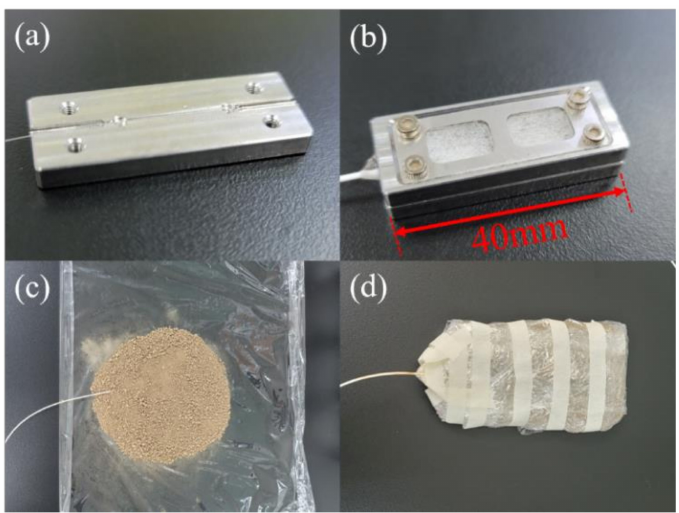
Figure 2. Installation of the experimental set-up. ( a ) The POFBG positioned in the V-groove; ( b ) sensor probe: the POFBG in the stainless-steel package with polypropylene mat as a filter; ( c ) the sensor probe embedded in soils; ( d ) sensor probe wrapped up by polyethylene films.